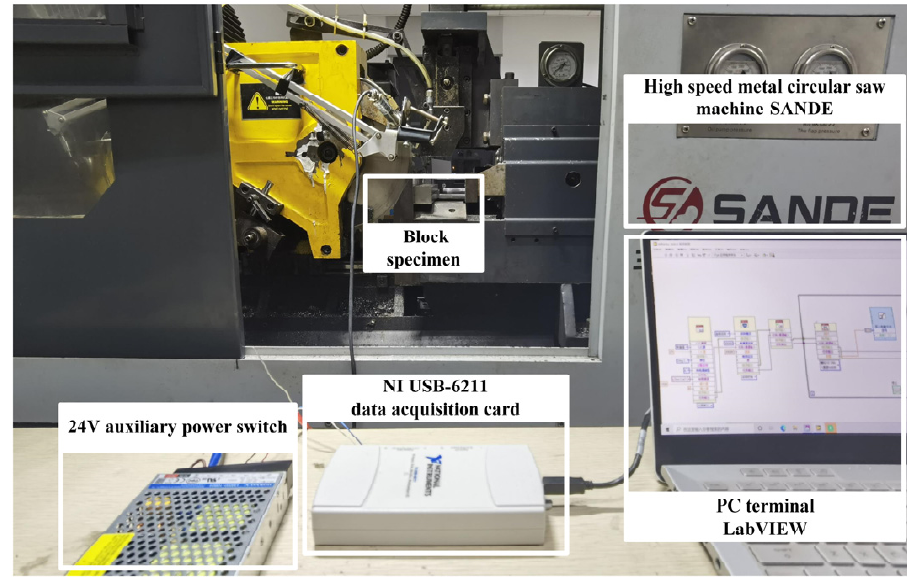
Figure 1. Experimental setup.